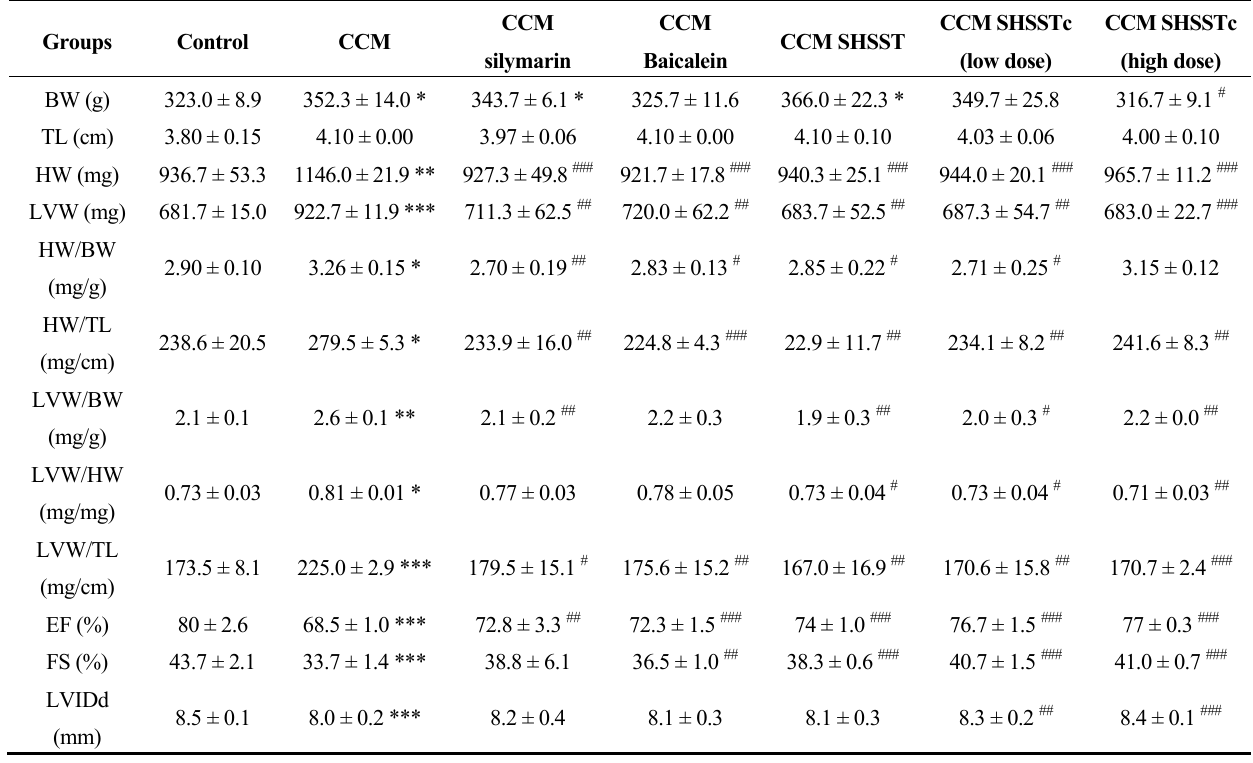
Table 1. Cardio vascular structure physiological characteristics